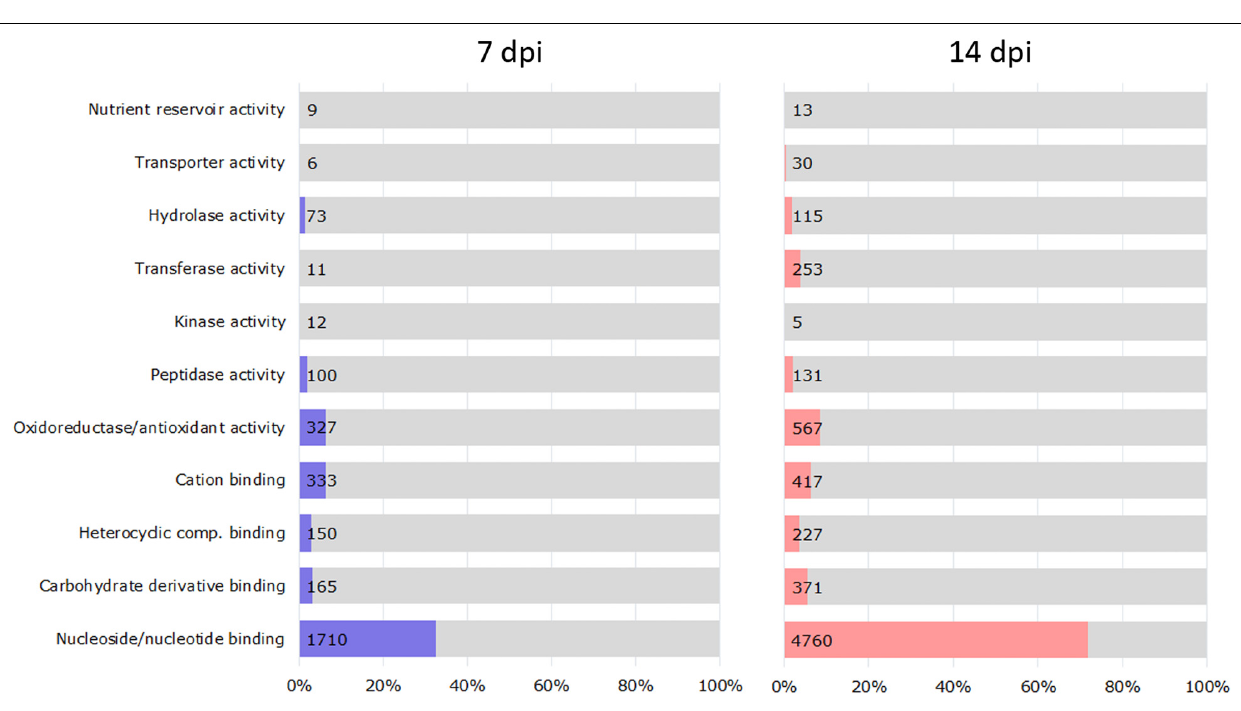
FIGURE 3 | Classification of DEGs based on enriched molecular function in RKN_WS at 7 and 14 dpi. The vertical axis indicates molecular function information, and the horizontal axis indicates the number and percentages of genes enriched in each category. Values were calculated respect to total RKN_WS DEGs [Fold change ≥ 2 or ≤ –2, p -value ≤ 0.05 and transcripts per million (TPM) ≥